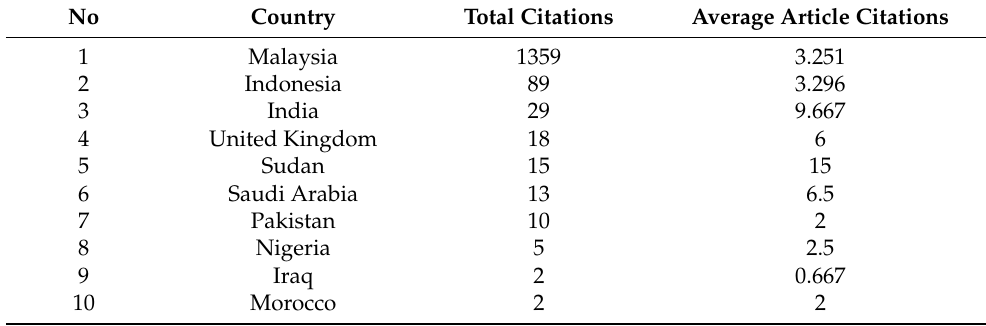
Table 4. The 10 Countries with the Most